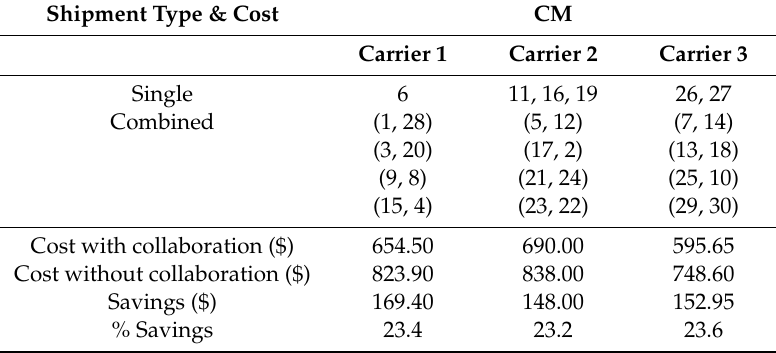
Table 5. Model outputs for the small-scale experiments.